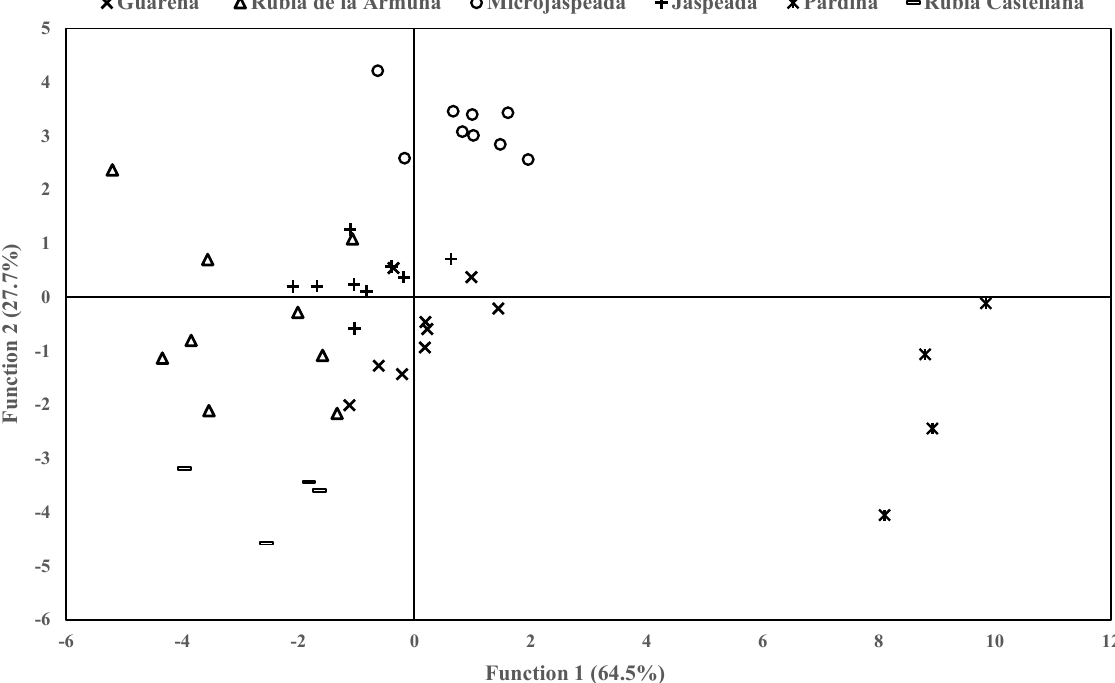
Figure 2. Scatter plot that shows the canonical or discriminant coordinates of the analyzed lentil samples. In brackets is the % variance that explains each of the canonical functions.